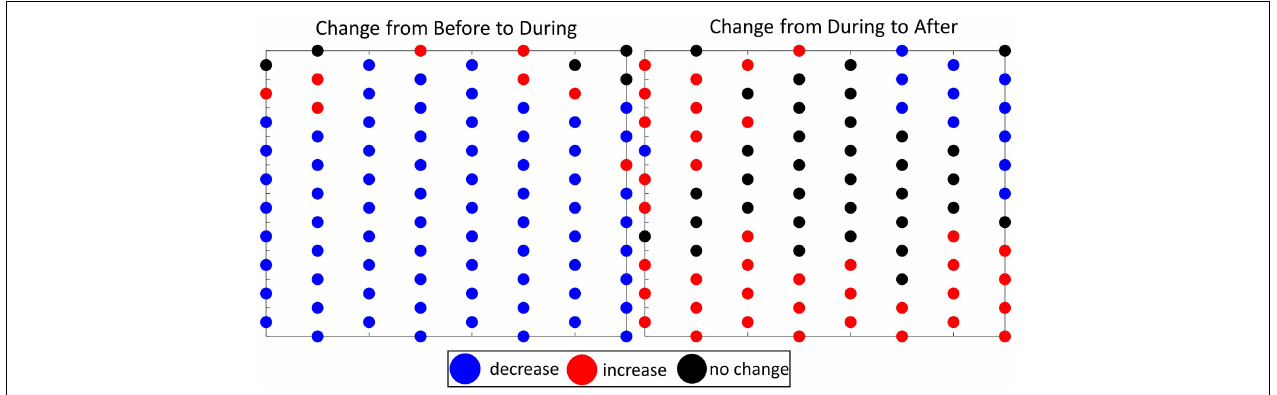
FIGURE 8 | Spatial layout of mock AUTEC hydrophone array, where the circles represent the hydrophones of the array, and the color represents the change in the number of GVP on each hydrophone from one analysis period to the next: blue = decrease, red = increase, black = no change. Left - the change from Before to During MFAS activity, and Right - the change from During to After MFAS activity.